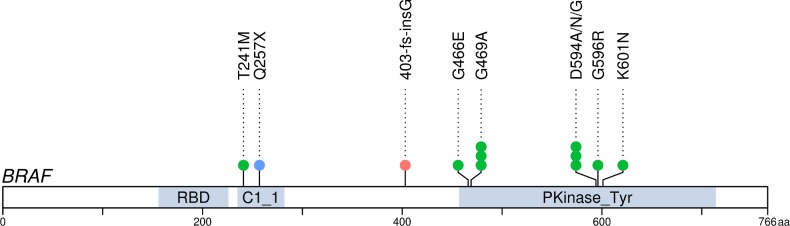
Mutations in BRAF (ENST00000288602).In total, 12 mutations were identified in 11 tumors (MSS n = 10, MSI n = 1). RBD = Raf-like Ras-binding domain; C1_1 = C1 domain; Pkinase_Tyr = Protein tyrosine kinase.